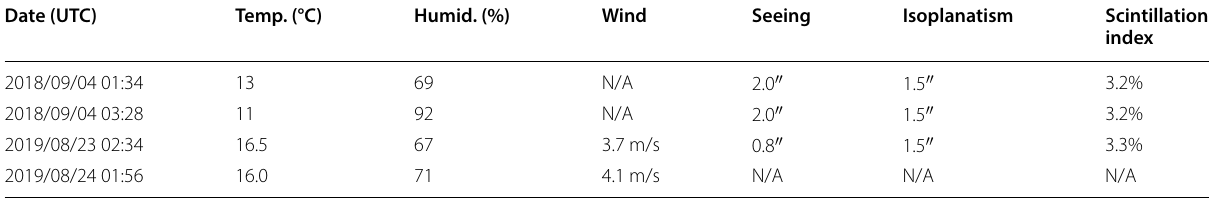
Table 1 Meteorological and atmospheric turbulence parameters during the successful LRO passes Date (UTC) Temp.